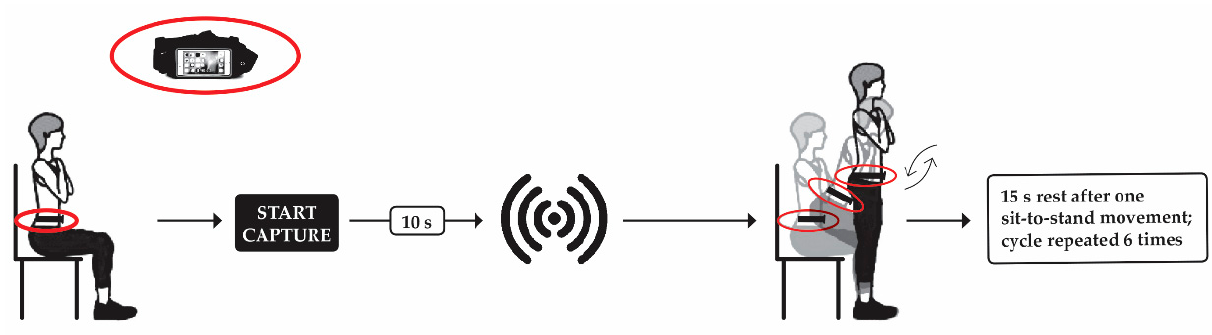
Figure 1. Illustration of the single sit-to-stand test.